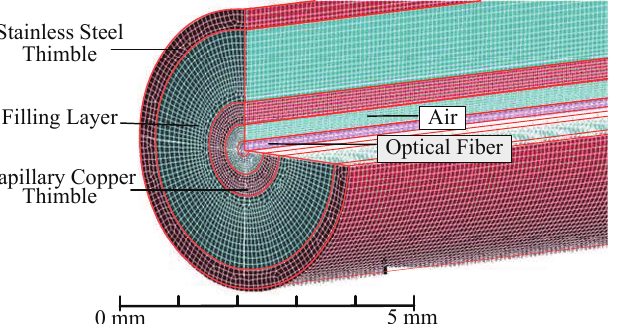
Figure 6. Finite element meshing diagram of FBG temperature sensor transient heat transfer model. The dynamic response of the sensor temperature field and the fiber grating tempera- ture at different moments can be obtained by solving the heat conduction process. When the ambient temperature jumps positively from 20 to 80 ◦ C, as shown in Figure 7a, the time constants of positive temperature jumps of the air-medium FBG sensor, grease-medium FBG sensor, and copper-medium FBG temperature are 109 s, 137 s, and 190 s, respectively. When the ambient temperature jumps negatively from 80 to 20 ◦ C, as shown in Figure 7b, the time constant is 123 s, 149 s, and 209 s, correspondingly. So, the time constant of positive temperature jump is shorter than time constant of negative temperature jump, response speed depends on whether the sensor is heated or cooled, and packaging materials with different thermal conductivity have a greater impact on response speed. In the heating or cooling process, the temperature response speed of each point inside the sensor is also different. As shown in Figure 8a,b, the difference of the response speed between the surface and the axis of the air-medium FBG sensor is nearly 40 s; however, for the grease-medium FBG sensor and the copper-medium FBG sensor, the temperature response speed of surface and the axis have only a 2-s difference in the heating process shown in Figure